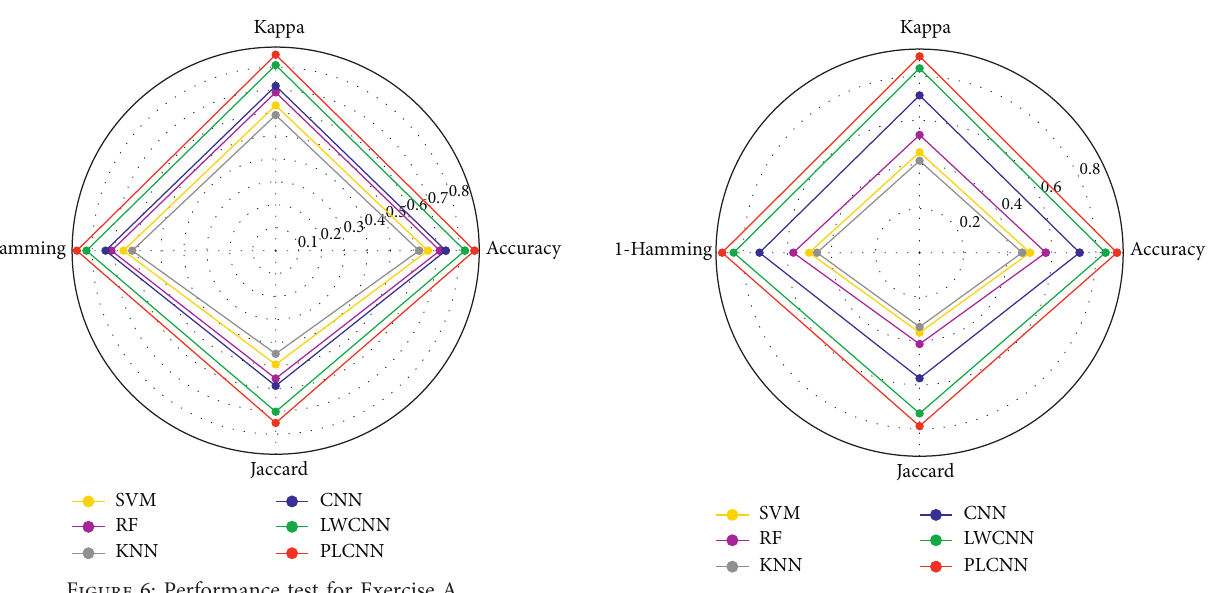
Figure 8: Performance test for Exercise